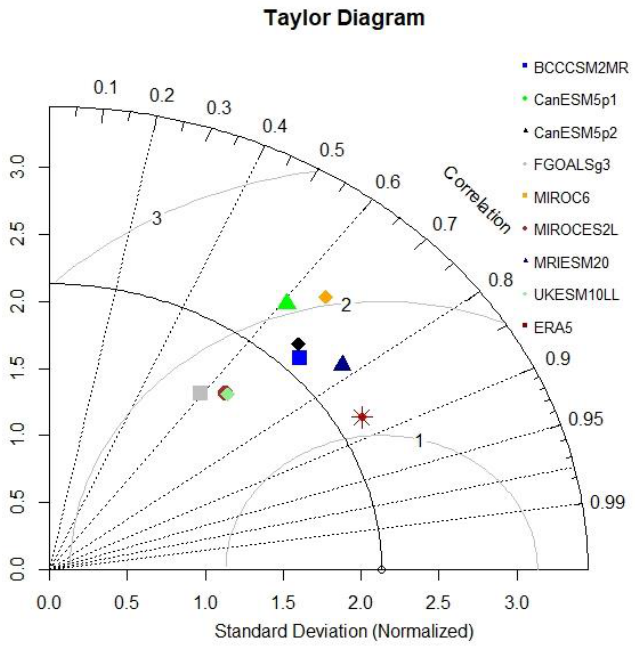
Figure 4. Taylor diagram comparing the temporal performances of nine CMIP6 models maximum